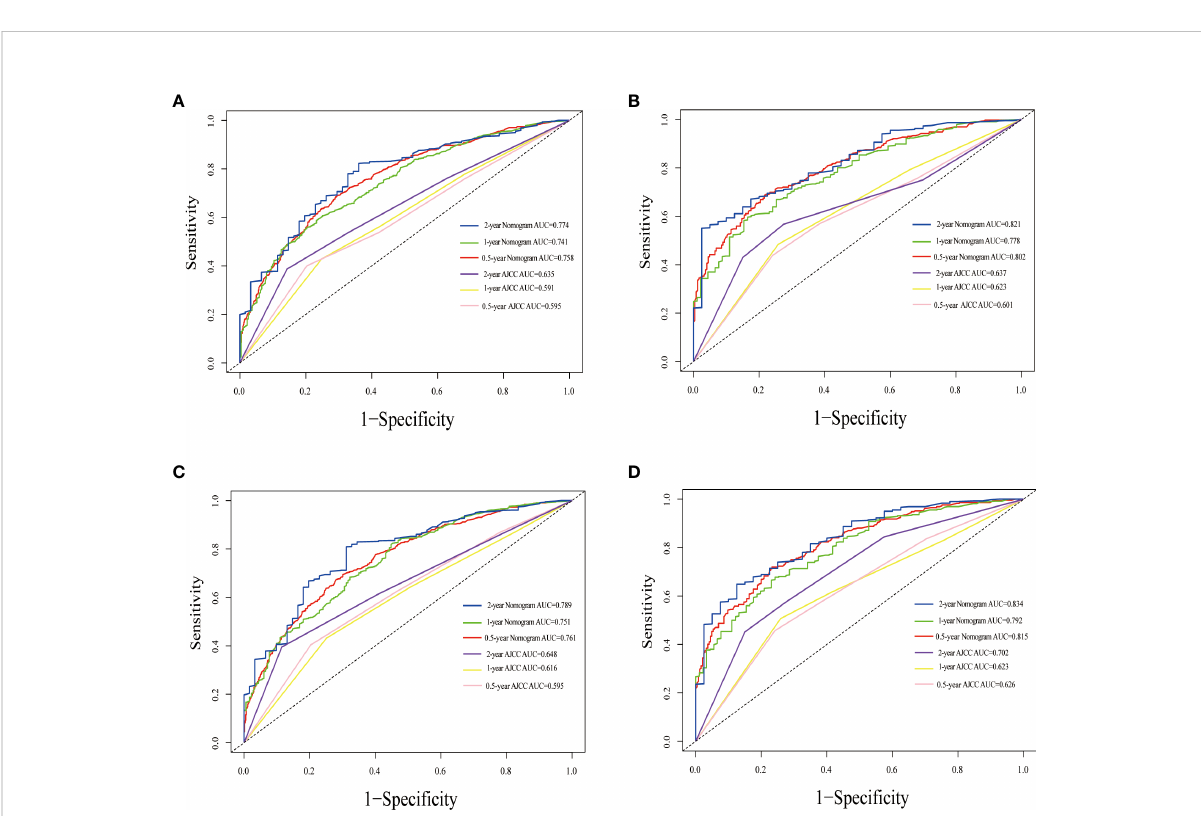
FIGURE 4 Time-dependent ROC curves comparing the use of the Nomogram and AJCC TNM staging system to predict the 0.5-, 1- and 2-year OS and CSS in the training cohort (A, C) , the internal validation cohort (B, D)